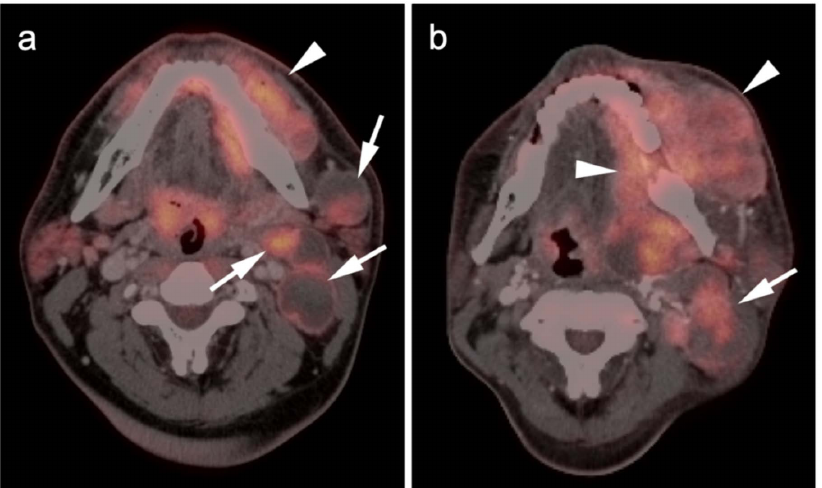
Figure 10. Mucosal melanoma of the oral cavity. Axial FDG PET-CT images of the face. ( a ) At initial diagnosis there is a large, moderately hypermetabolic mass centered in the left submandibular space, medial and lateral to the left mandible (white arrow). There are also multiple involved partially cystic lymph nodes (white arrow). ( b ) At follow-up on treatment 3 months later, there is progressive enlargement of the mass in the left oral cavity (white arrowhead) and persistent nodal disease (white